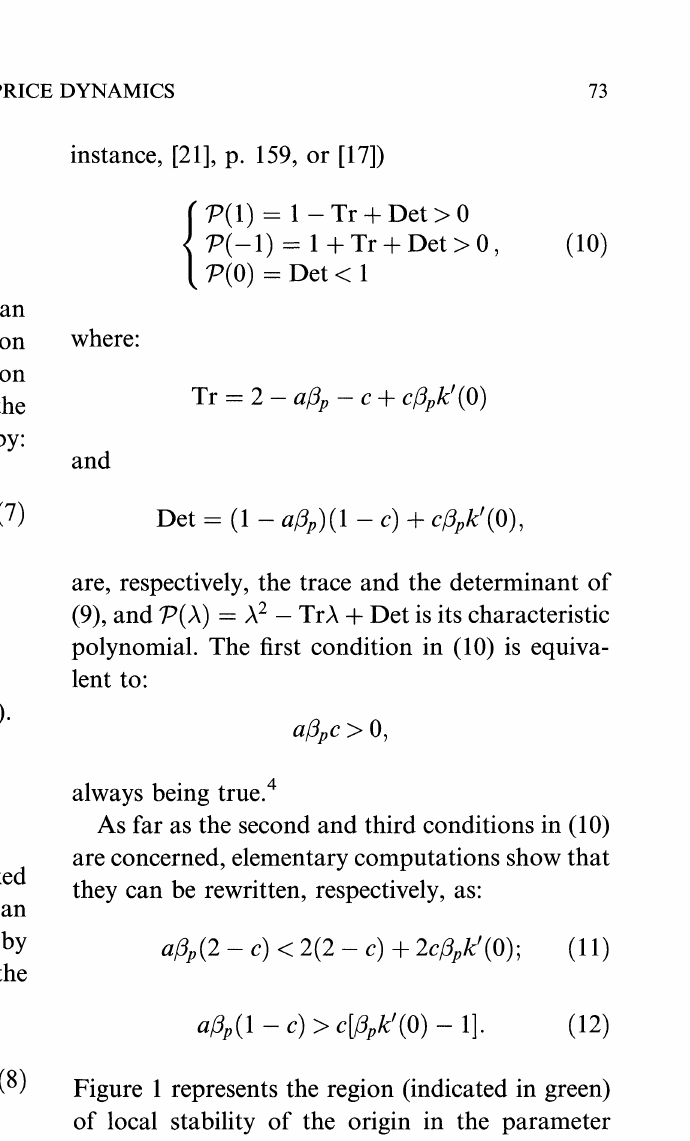
Figure represents the region (indicated in green) of local stability of the origin in the parameter plane (e, a), c > 0, a > 0. The shape of this region is affected by the remaining parameters, strength of chartists’ demand at the steady state (k’(0)) and the speed of adjustment of market price (tip). From a qualitative point of view, we can distinguish two cases: case A (represented in Fig. a), with /3pk’(O) _< 1, and case B (Fig. b), with/pkt(O) > 1. From Eqs. (11) and (12) it follows that starting from inside the stability region in the